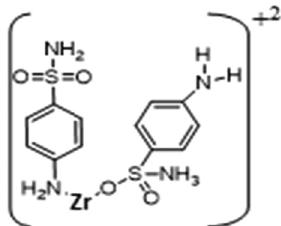
Figure 2: Complex ( 1 ) .